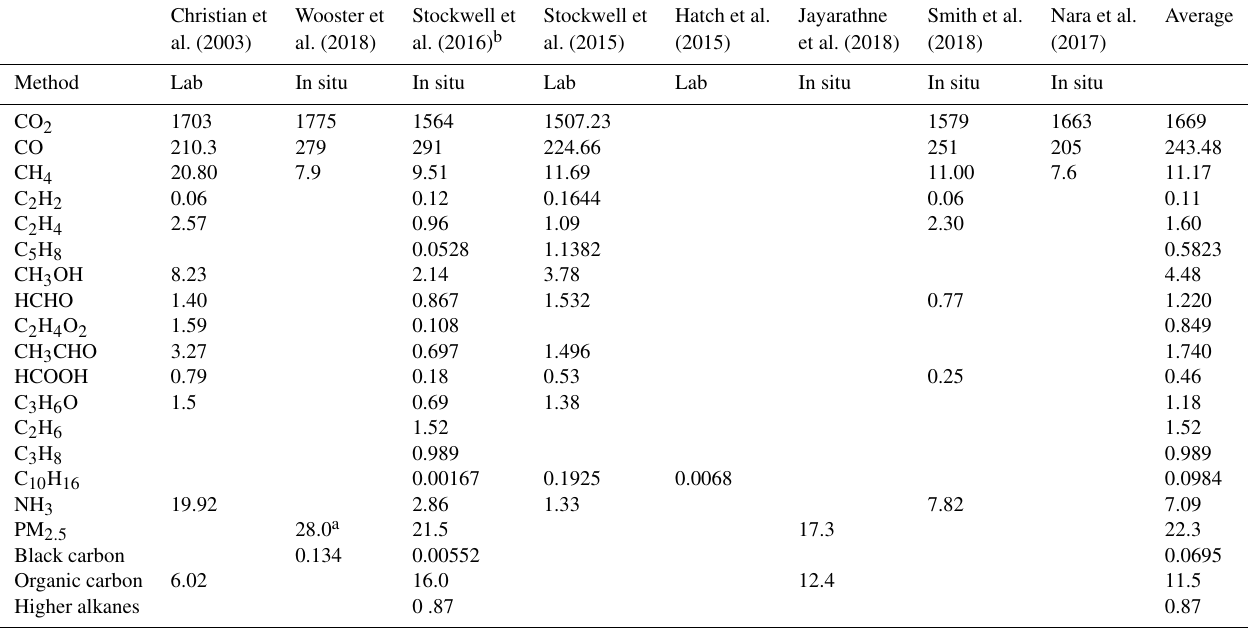
Table 2. Emission factors from previous studies (gkg − 1 ) and an average value across all studies. Christian et